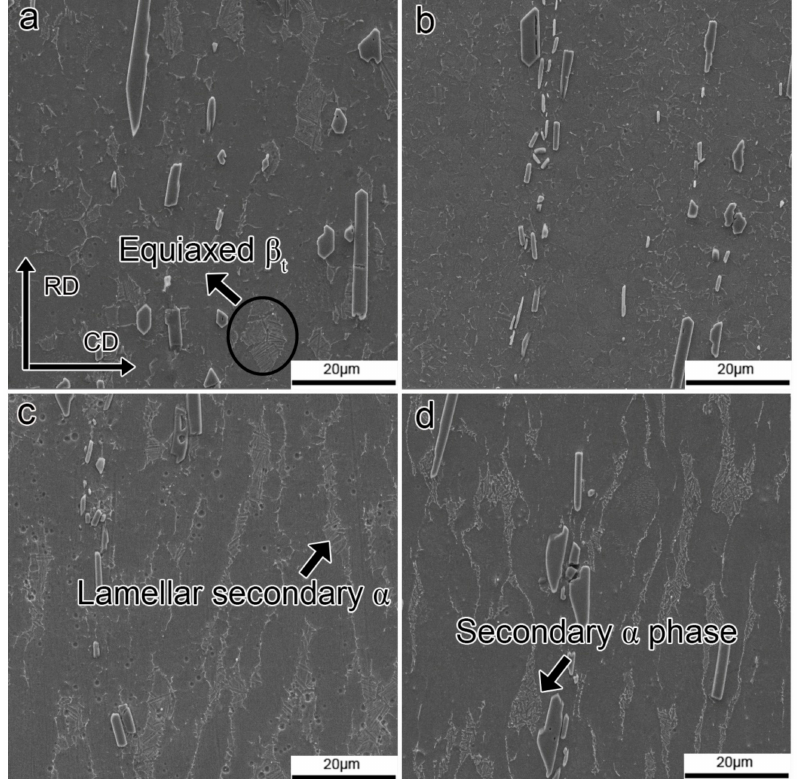
Figure 8. Microstructure of 7.5 vol.% TiB w / near α -Ti composite deformed at 900 ◦ C with di ff erent strain